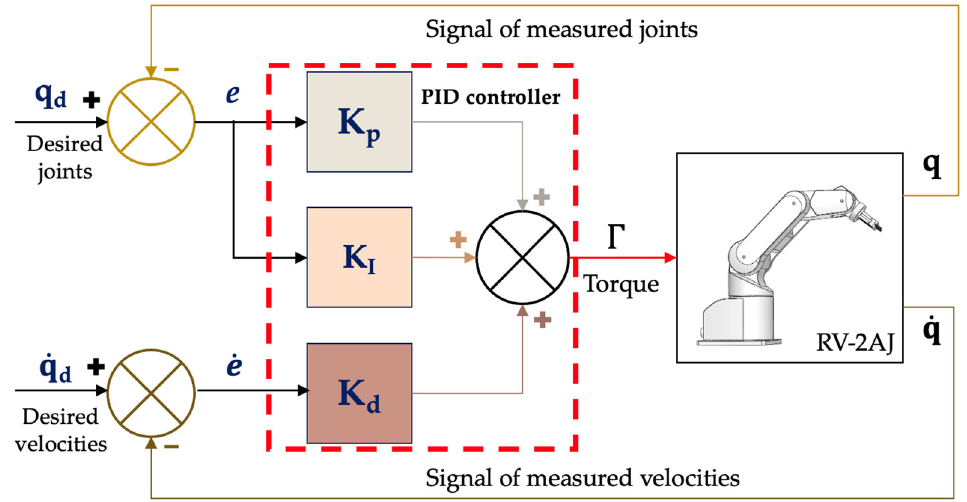
Figure 4. Structure of PID controller.